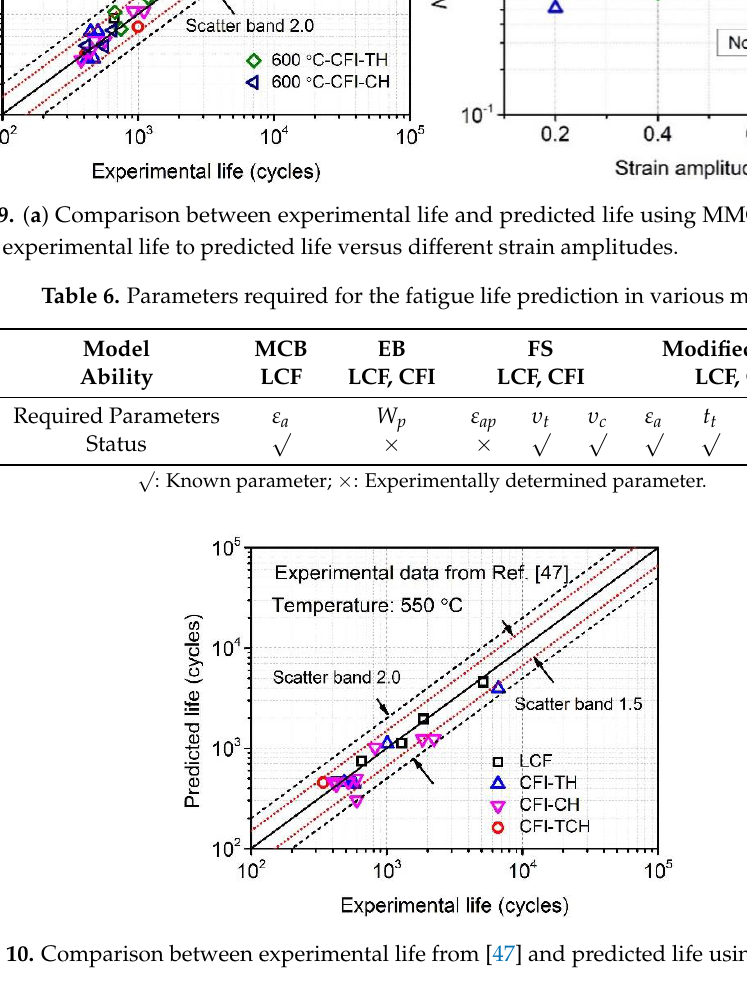
√: Known parameter; ×: Experimentally determined parameter.